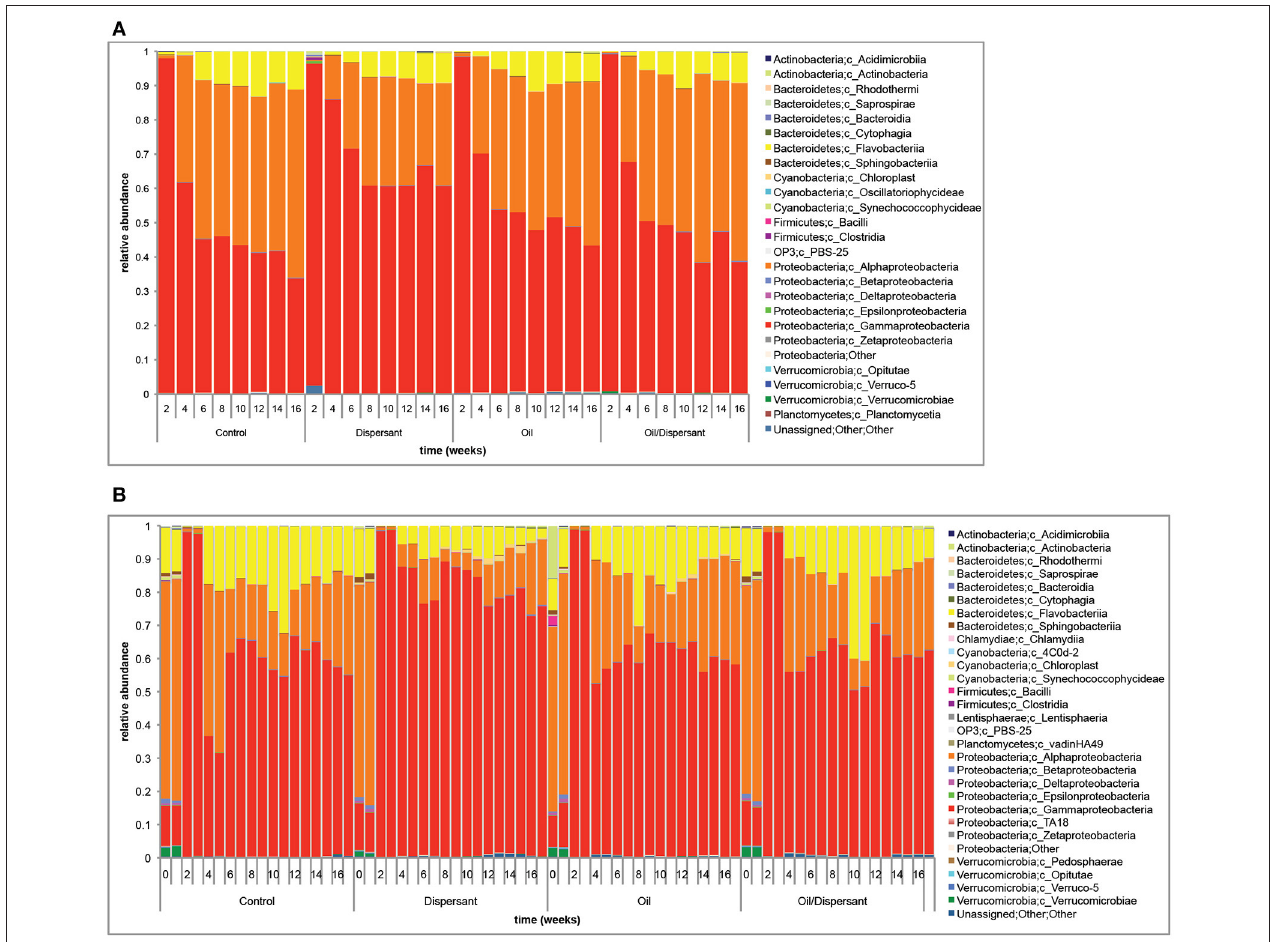
FIGURE 2 | (A) Bacterial community composition of carbon steel disk (CSD) biofilms from the four experimental treatments over time. Bacteria are identified to the Class taxonomic level. CSD biofilm samples were collected every 2 weeks during the 16-week experiment. (B) Bacterial community composition of SW bacterioplankton samples from the four experimental treatments over time. Bacteria are identified to the Class taxonomic level. Duplicate seawater samples were collected for SW bacterioplankton every 2 weeks during the 16-week